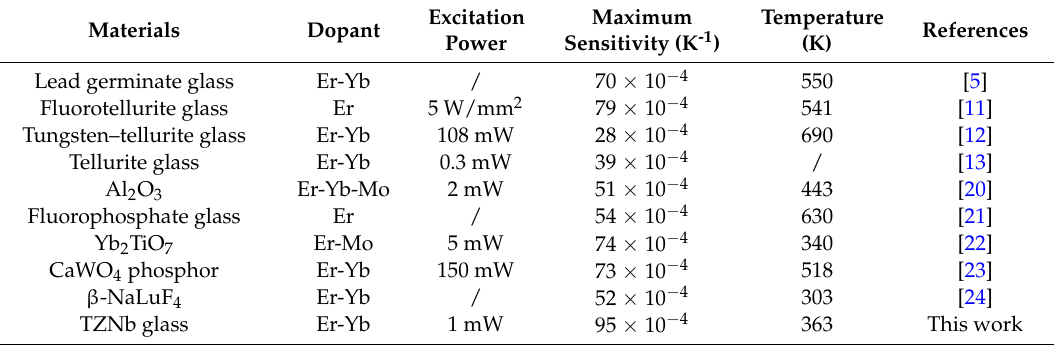
Table 2. Optical temperature sensing performance in the different Er 3+ doped host matrices. The dopant, excitation power, maximum sensitivity, and the corresponding temperature are